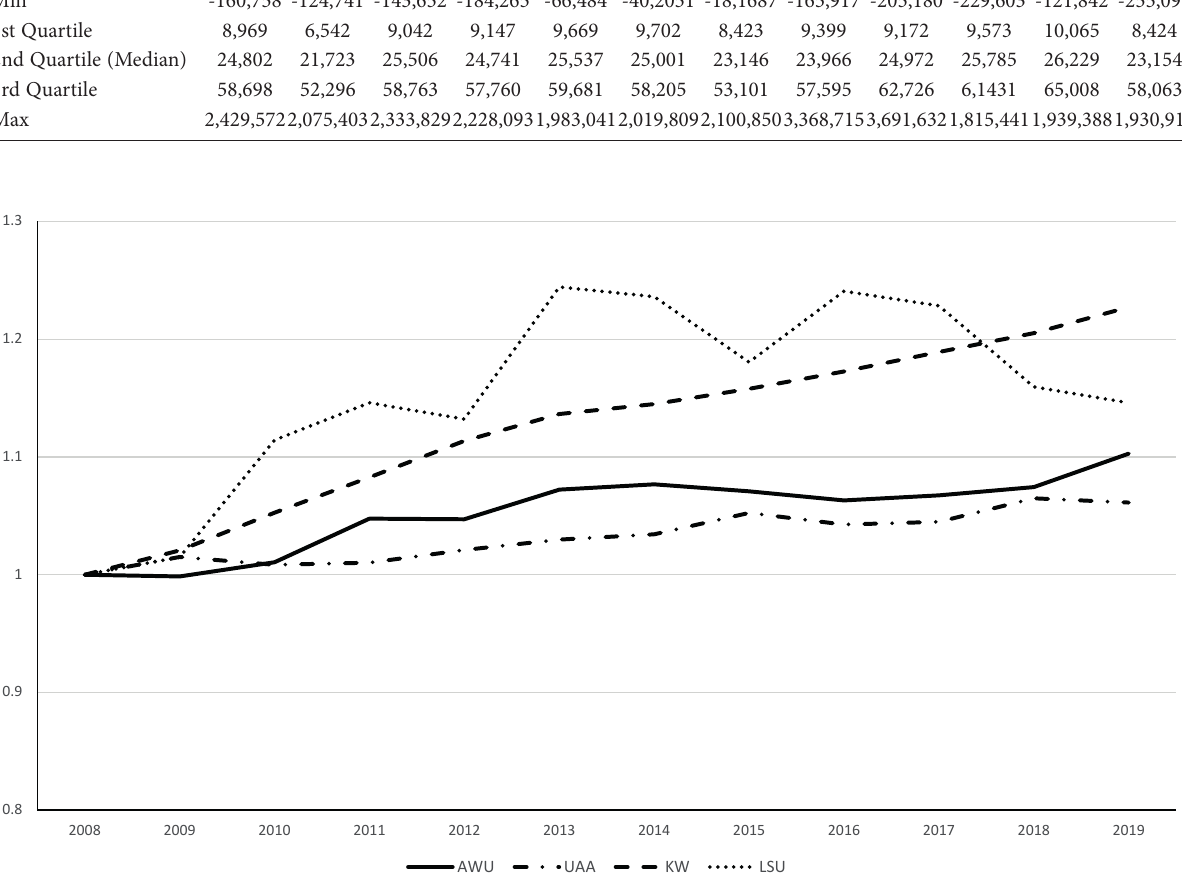
Figure 5. Evolution of main factors’ average endowment (2008=1) over the 2008-2019 period within the Italian FADN balanced